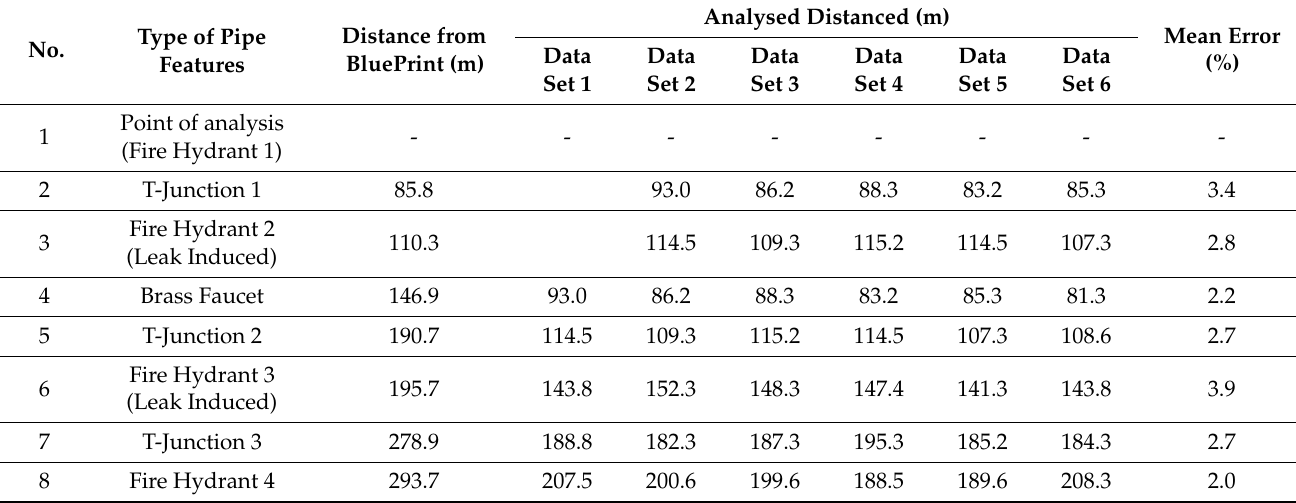
Table 7. NIKAZ evaluation for a system with 5 mm leak induced on fire hydrants 1 and